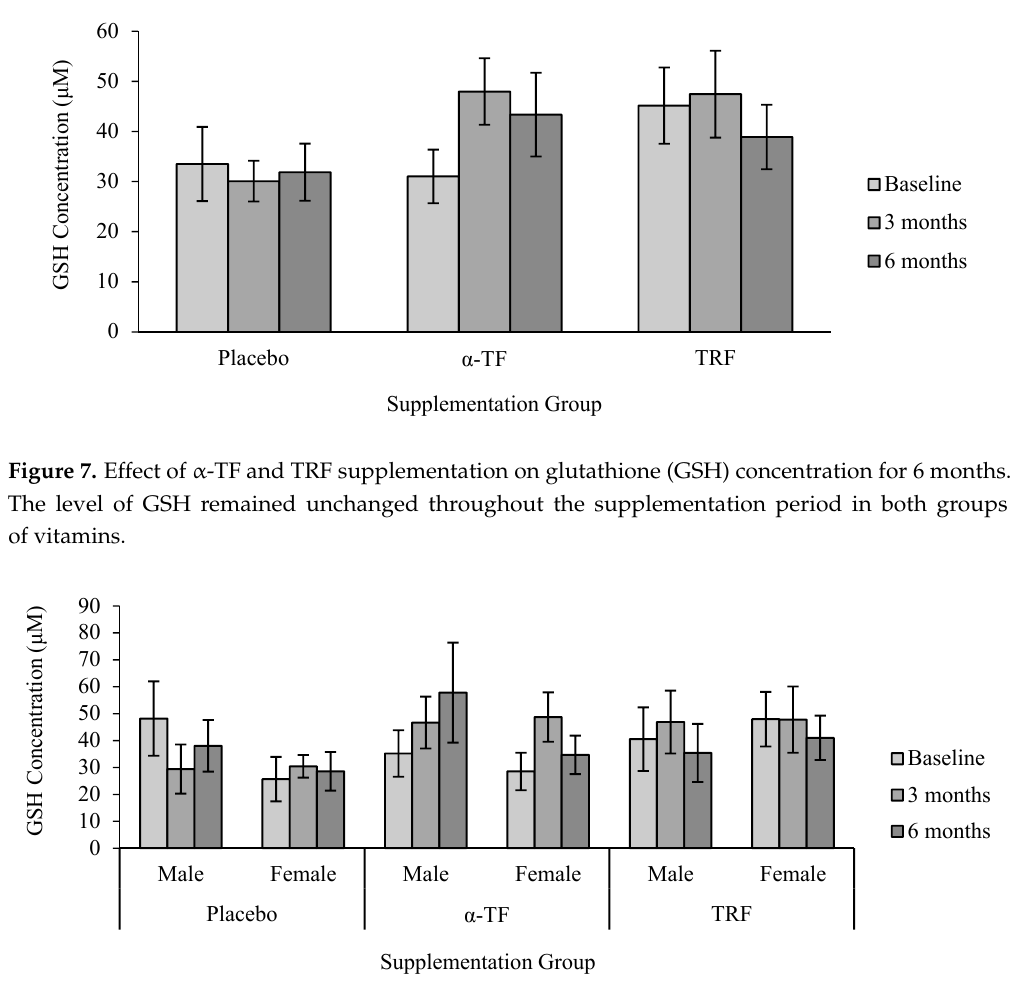
6.0 0.01.02.03.04.05.0